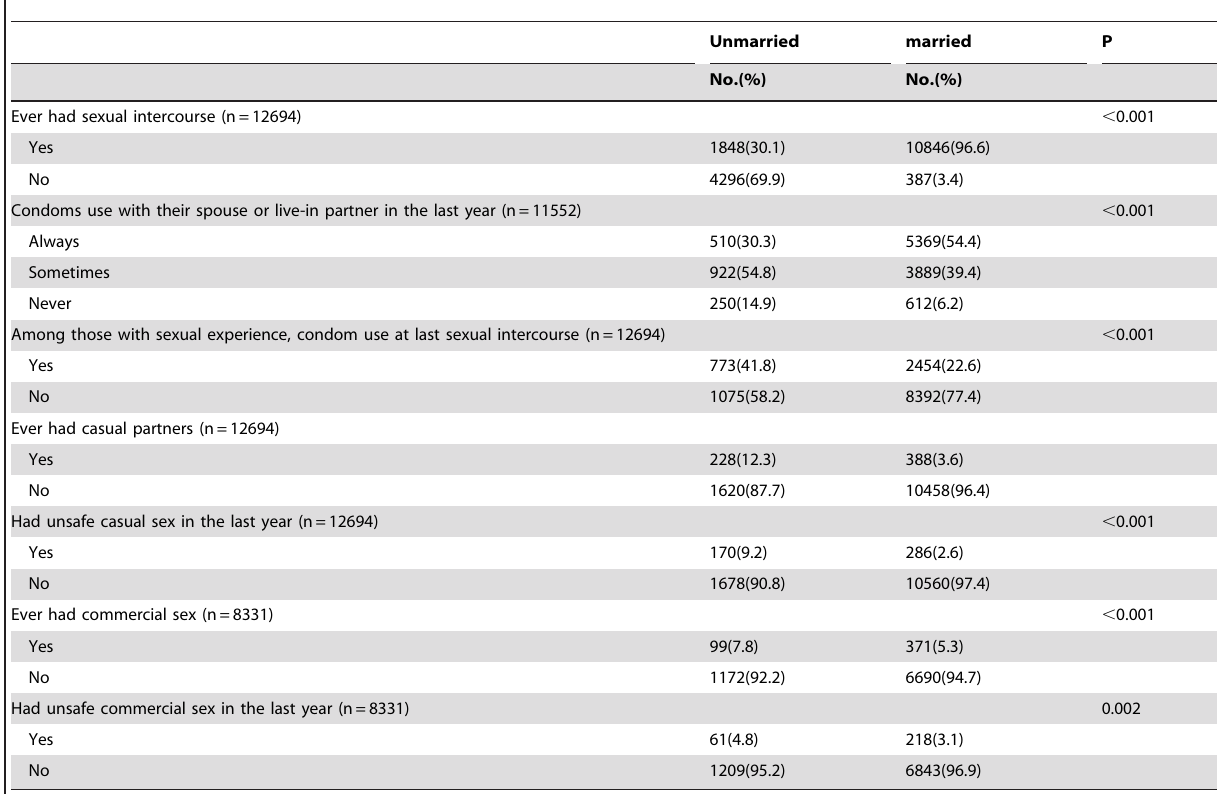
Table 2. Sexual behavior and condom usage by marital